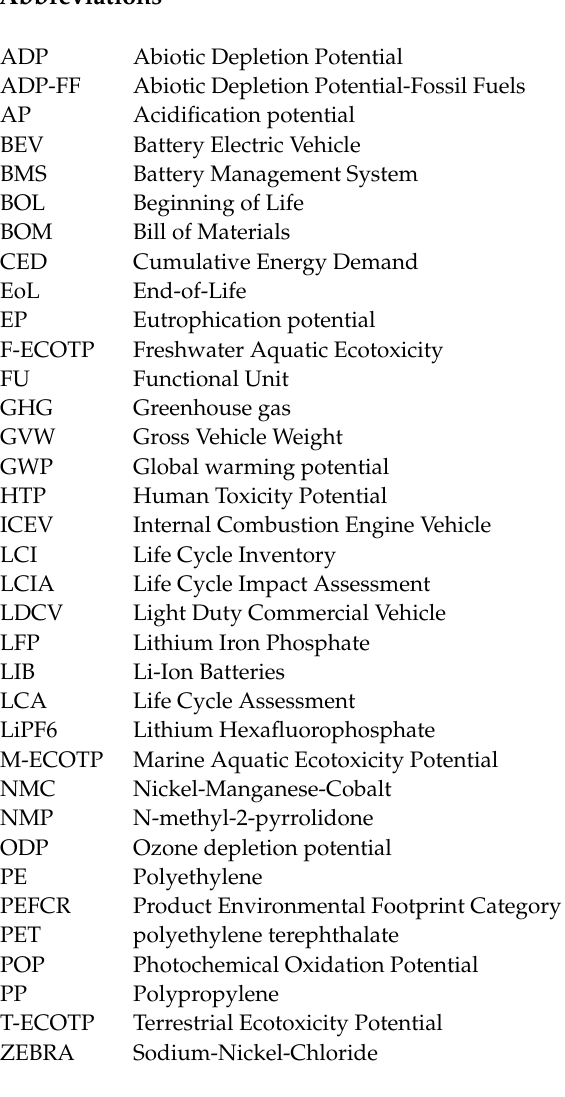
Table S25: Impact assessment of Zebra battery per kWh, Table S26: Impact assessment of DIE-ICEV per km, Table S27: Impact assessment of NMC-BEV per km (first scenario with 2 NMC battery packs), Table S28: Impact assessment of NMC-BEV per km (second scenario with 3 NMC battery packs), Table S29: Impact assessment of ZEBRA-BEV per km, Table S30: Monte Carlo analysis, Table S31: Monte Carlo analysis, Table S32: Monte Carlo analysis. Comparison between battery production in China and in Europe in the second scenario (3 NMC battery packs power the